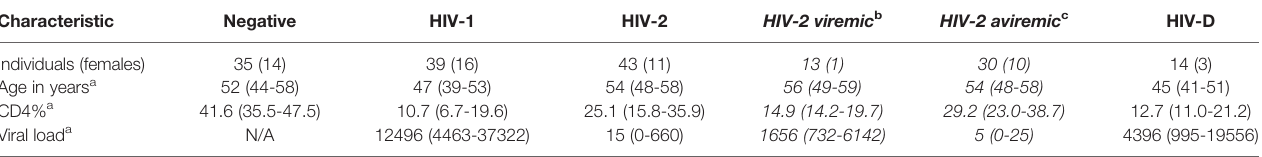
TABLE 1 | Characteristics of study participants included in the qPCR analysis.